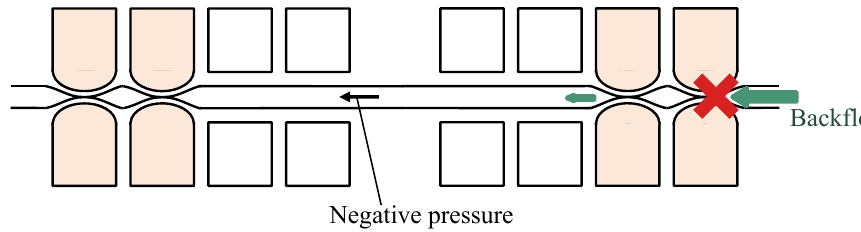
Figure 12. Mechanism for reducing backflow of the series